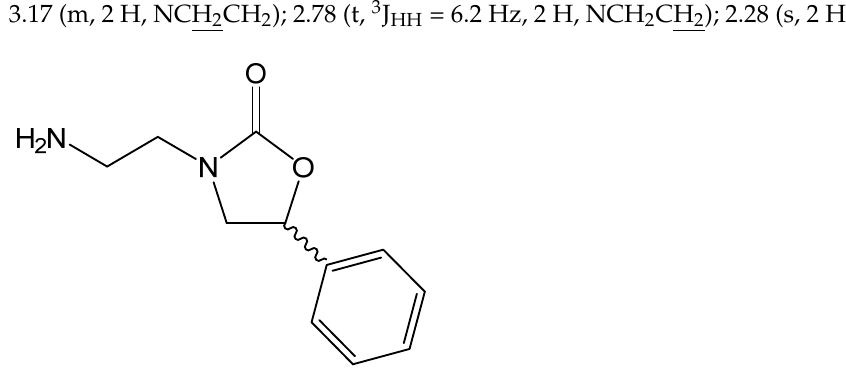
Figure 4. Structure of NH 2OX